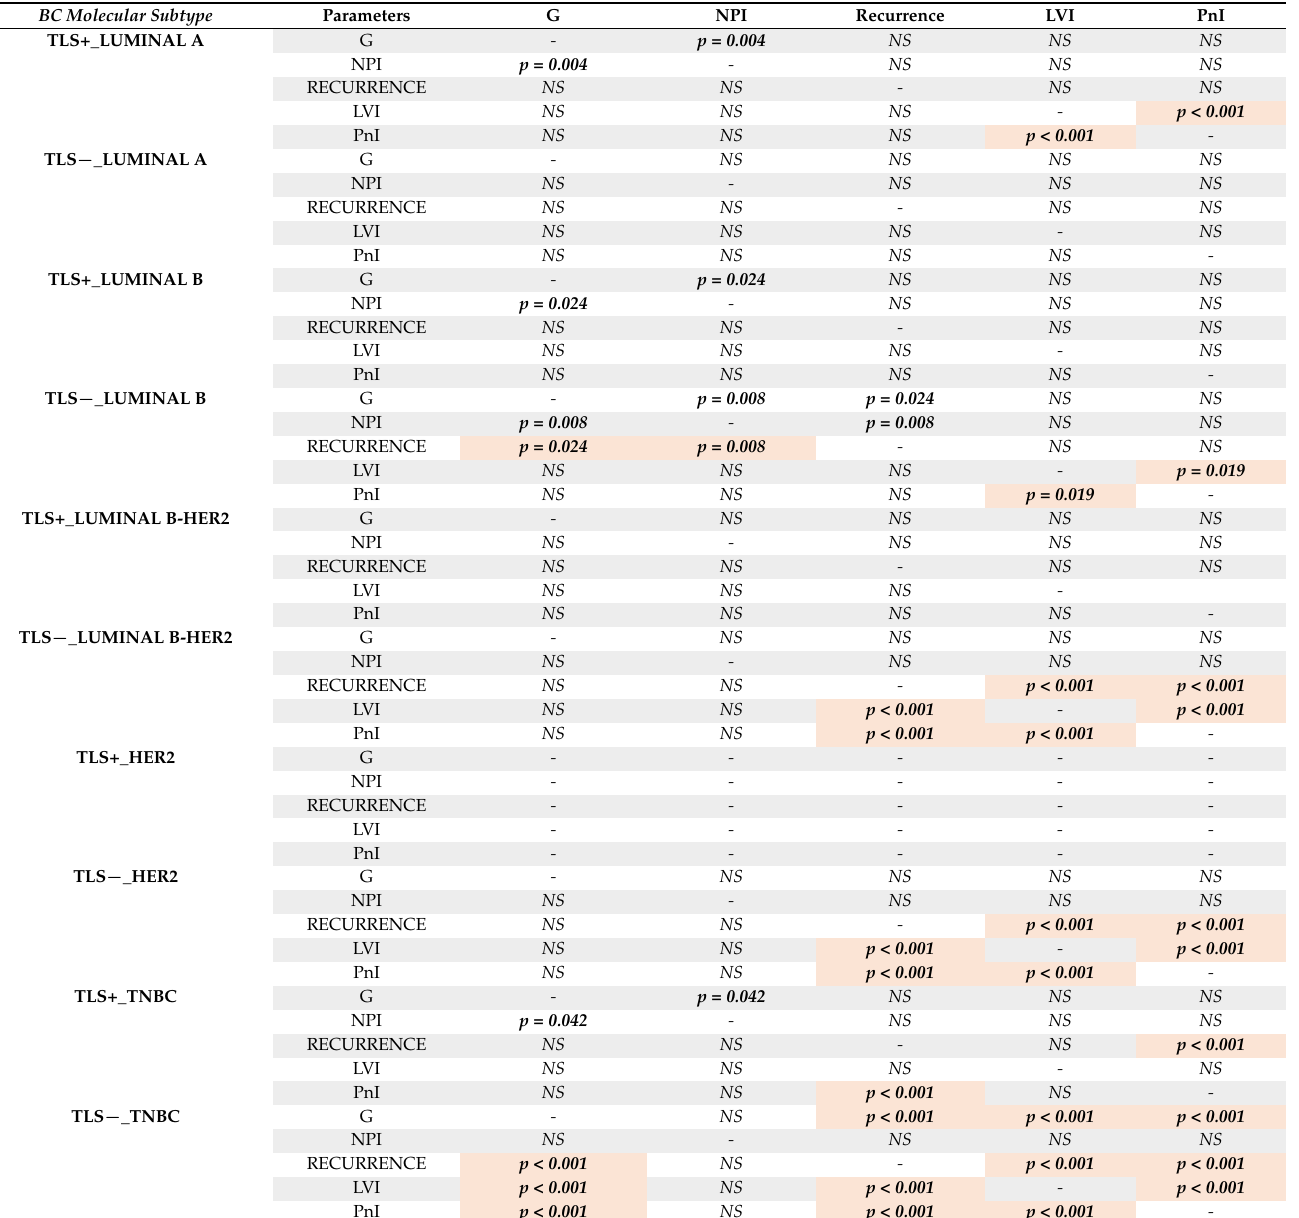
Table 1. Significant correlations between TLS − and TLS+ subgroups from each molecular subtype to G, NPI, LVI, PnI, and